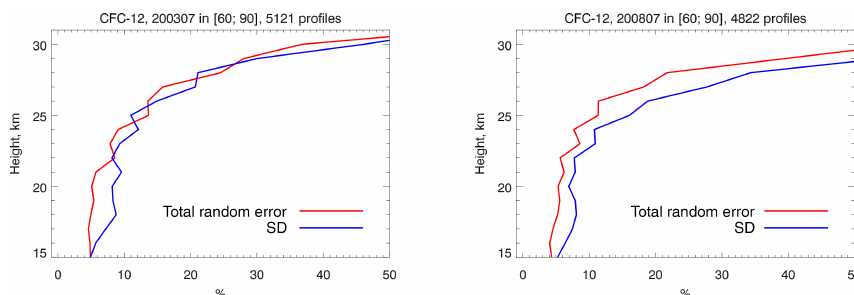
Figure 33. Analysis of MIPAS CFC-12 measurement error in quiescent atmospheric conditions (polar summer). Left panel: FR period; right panel: RR